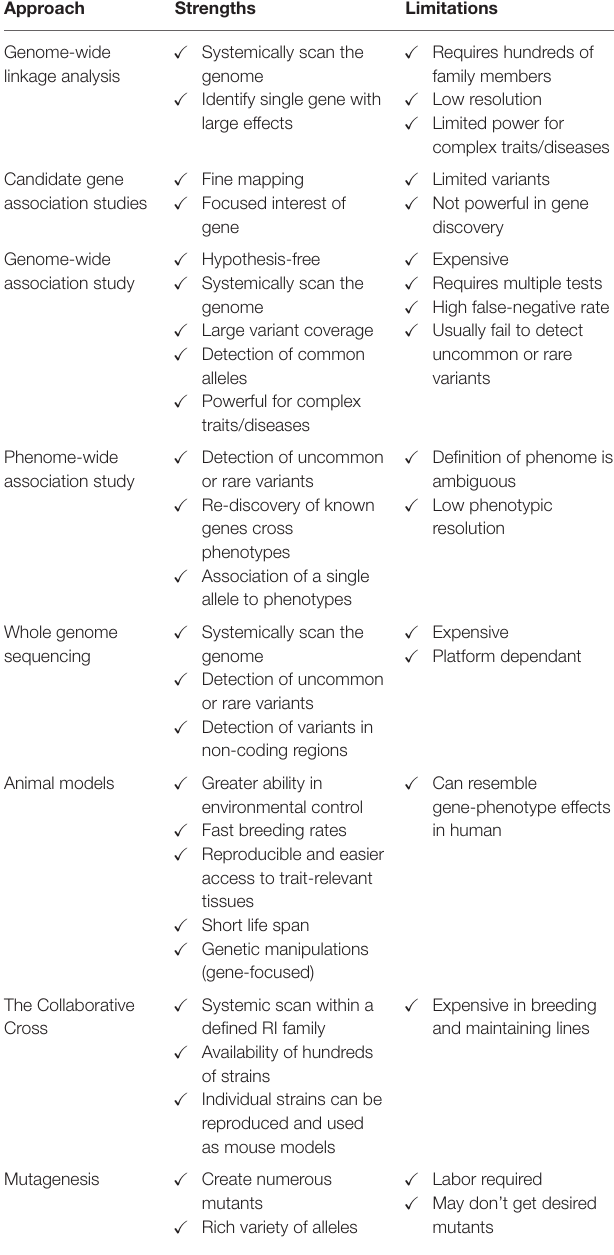
TABLE 2 | Comparison of genetic